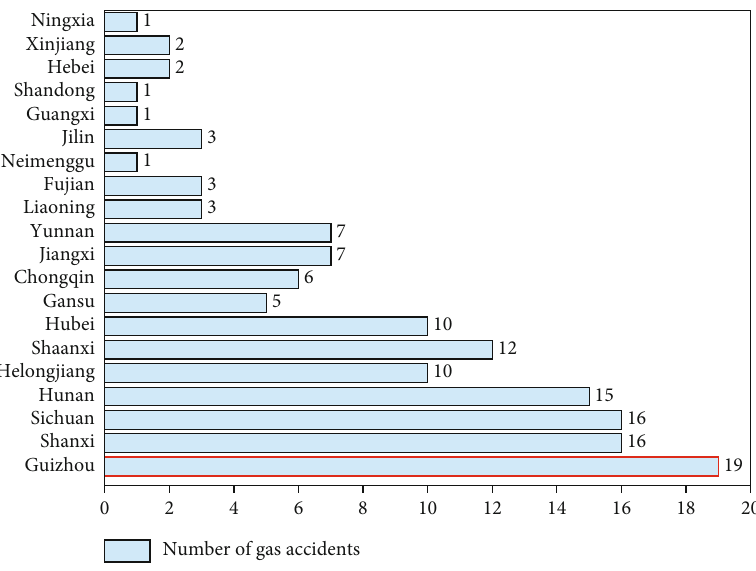
Figure 1: Regional distribution of coal mine gas accidents in China from 2015 to